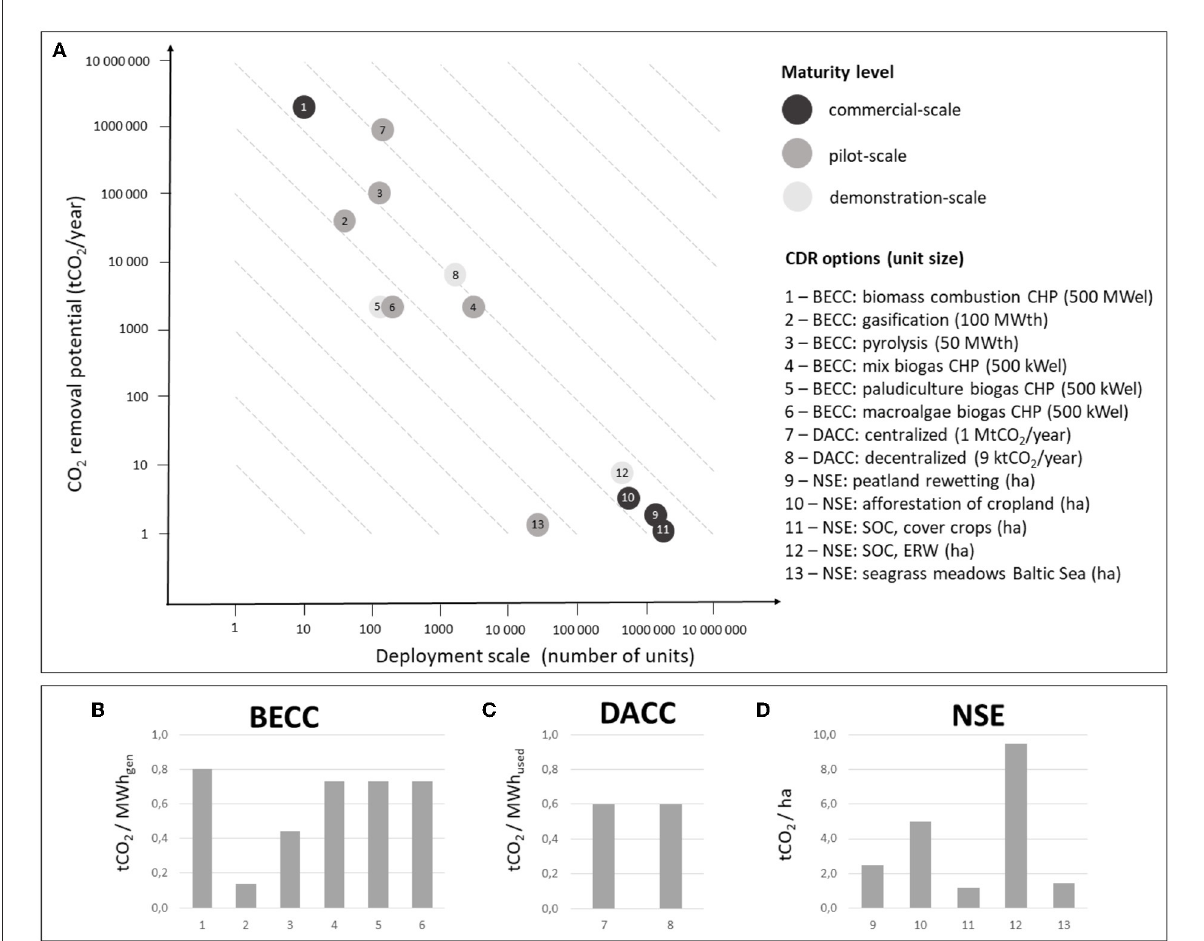
FIGURE2 Overview of CO 2 removal potential of selected options. (A) Scalability of options expressed as a number of units available for deployment by 2050 and CO 2 removal potential. (B) Amount of CO 2 removed per unit of energy generated by BECC technologies. (C) Amount of CO 2 removed per unit of energy used by DACC technologies. (D) Amount of CO 2 removed per hectare by NSE